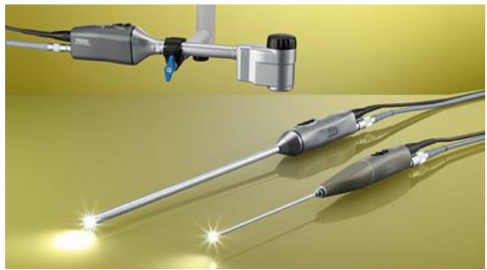
Figure 2. IMAGE1 STM D3-LINK Module with TIPCAM ® 1 STM 3D, 10 and 4 mm diameter, available